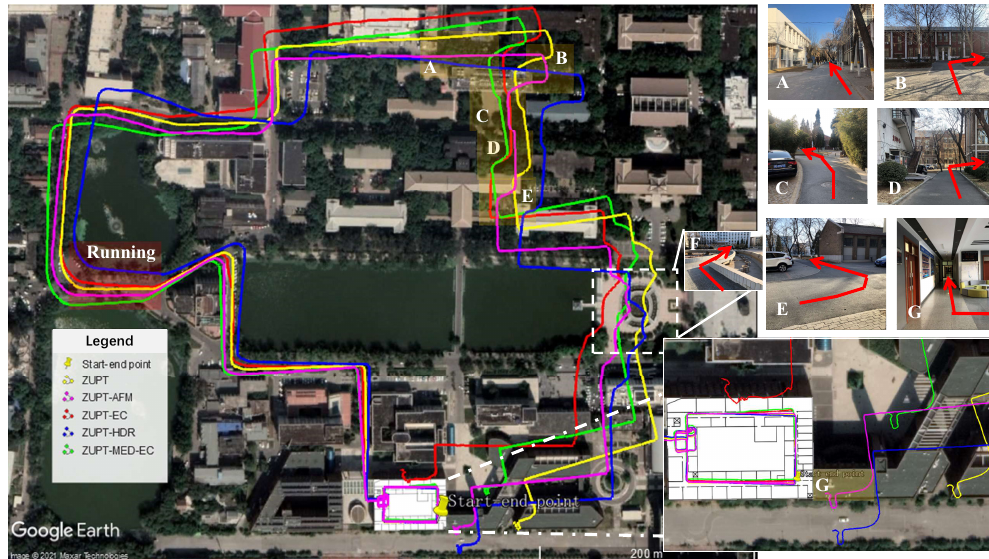
Figure 15. Estimated trajectories of the different frameworks on the indoor–outdoor 2 km sub-dataset. Subfigures A – G show different environments in this experiment. The red arrows in all subfigures refer to moving directions. Compared with the indoor–outdoor 1.9 km sub-dataset, there were many irregular trajectories (e.g. subfigures A – F ) in the 2 km sub-dataset, such as sharp and big turns.